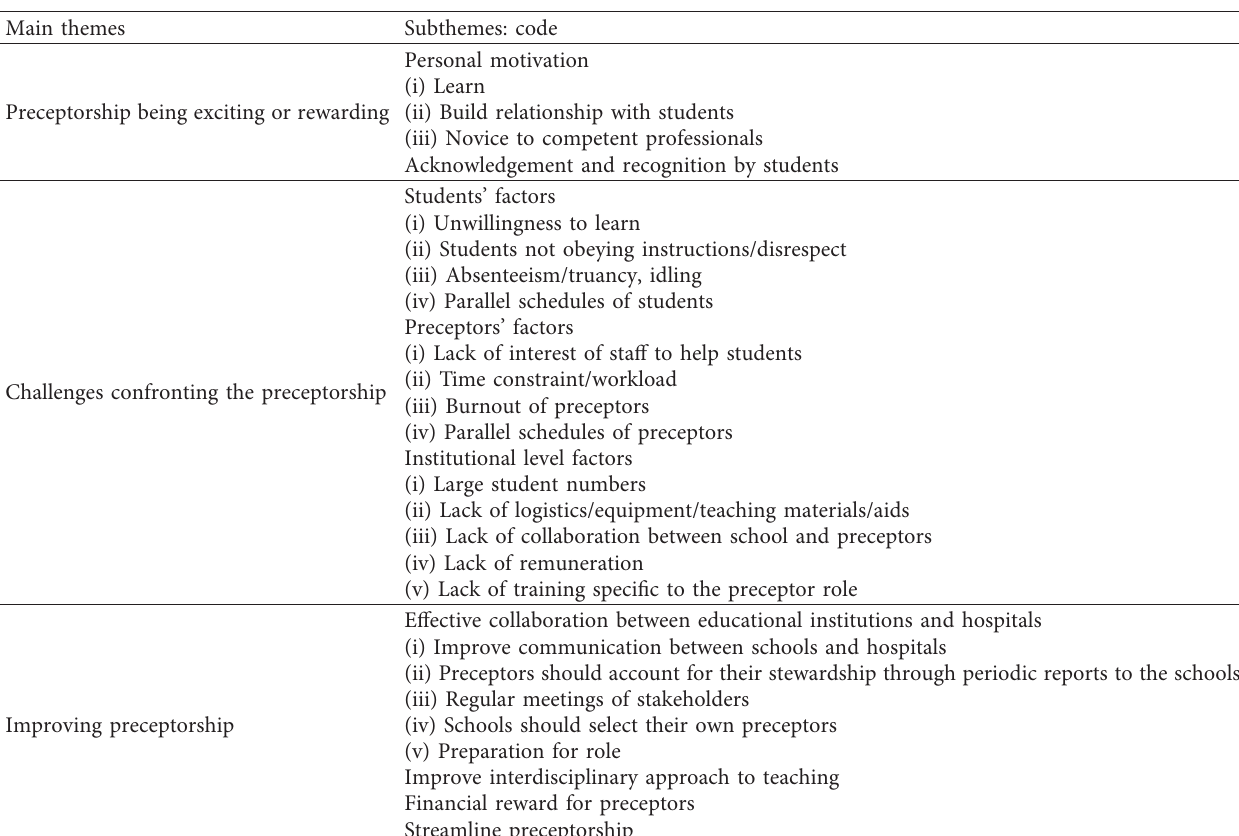
Table 2: Thematic